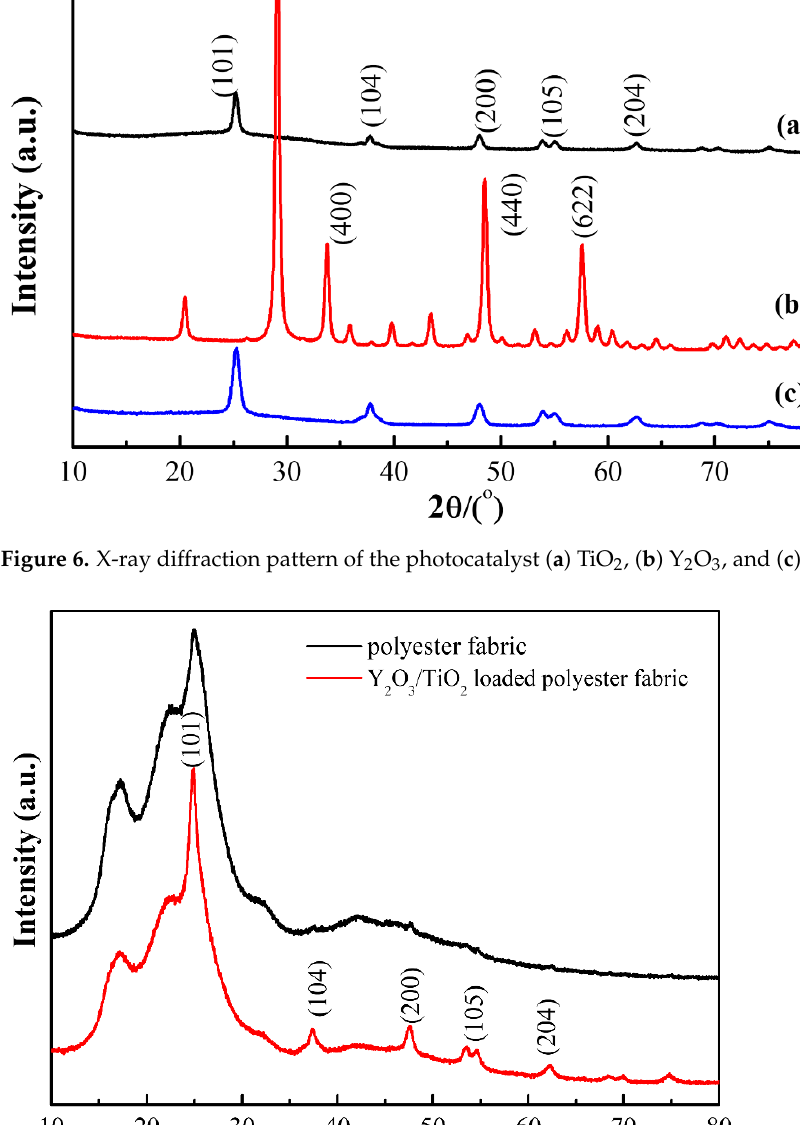
Figure 6. X-ray diffraction pattern of the photocatalyst ( a ) TiO 2 , ( b ) Y 2 O 3 , and ( c ) Y 2 O 3 /TiO 2 .